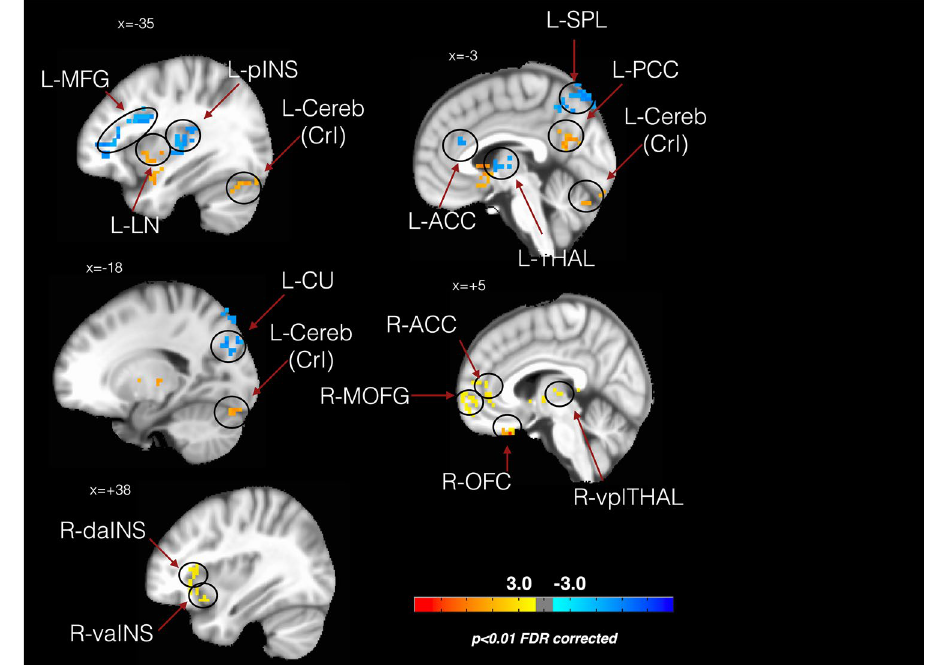
Figure 1. The effects of osteopathic treatment on regional cerebral flow. The figure shows CBF changes baseline-controlled group differences between treatment and sham group at T2 (referring to the contrast described in the text as (T2_OMT–T0_OMT) vs (T2_SHAM–T0_SHAM)— p < 0.01, false discovery rate (FDR) corrected). L-MFG left middle frontal gyrus, L-pINS left posterior insula, L-LN left lentiform nucleus, L-Cereb ( CrI ) left cerebellum (Crus I), L-ACC left anterior cingulate cortex, L-SPL left superior parietal lobe, L-PCC left posterior cingulate cortex, L-THAL left thalamus, L-CU left cuneus, R-ACC right anterior cingulate cortex, R-MOFG right mid orbitofrontal gyrus, R-OFC right orbito frontal cortex, R-vplTHAL right ventroposterior lateral thalamus, R-daINS right dorsal anterior insula, R-vaINS right ventral anterior